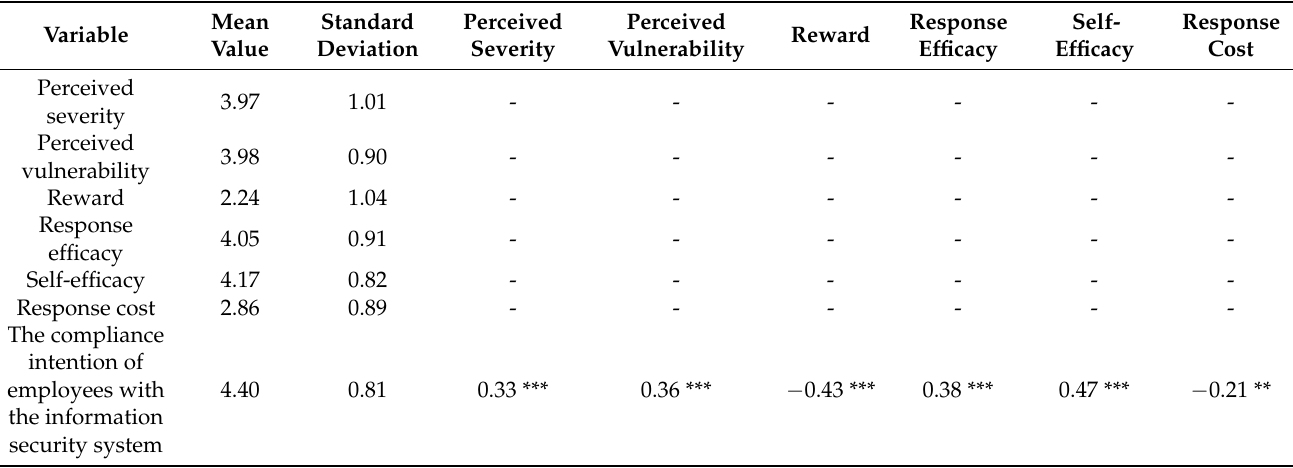
Table 4. Mean, standard deviation, and correlation coefficient.